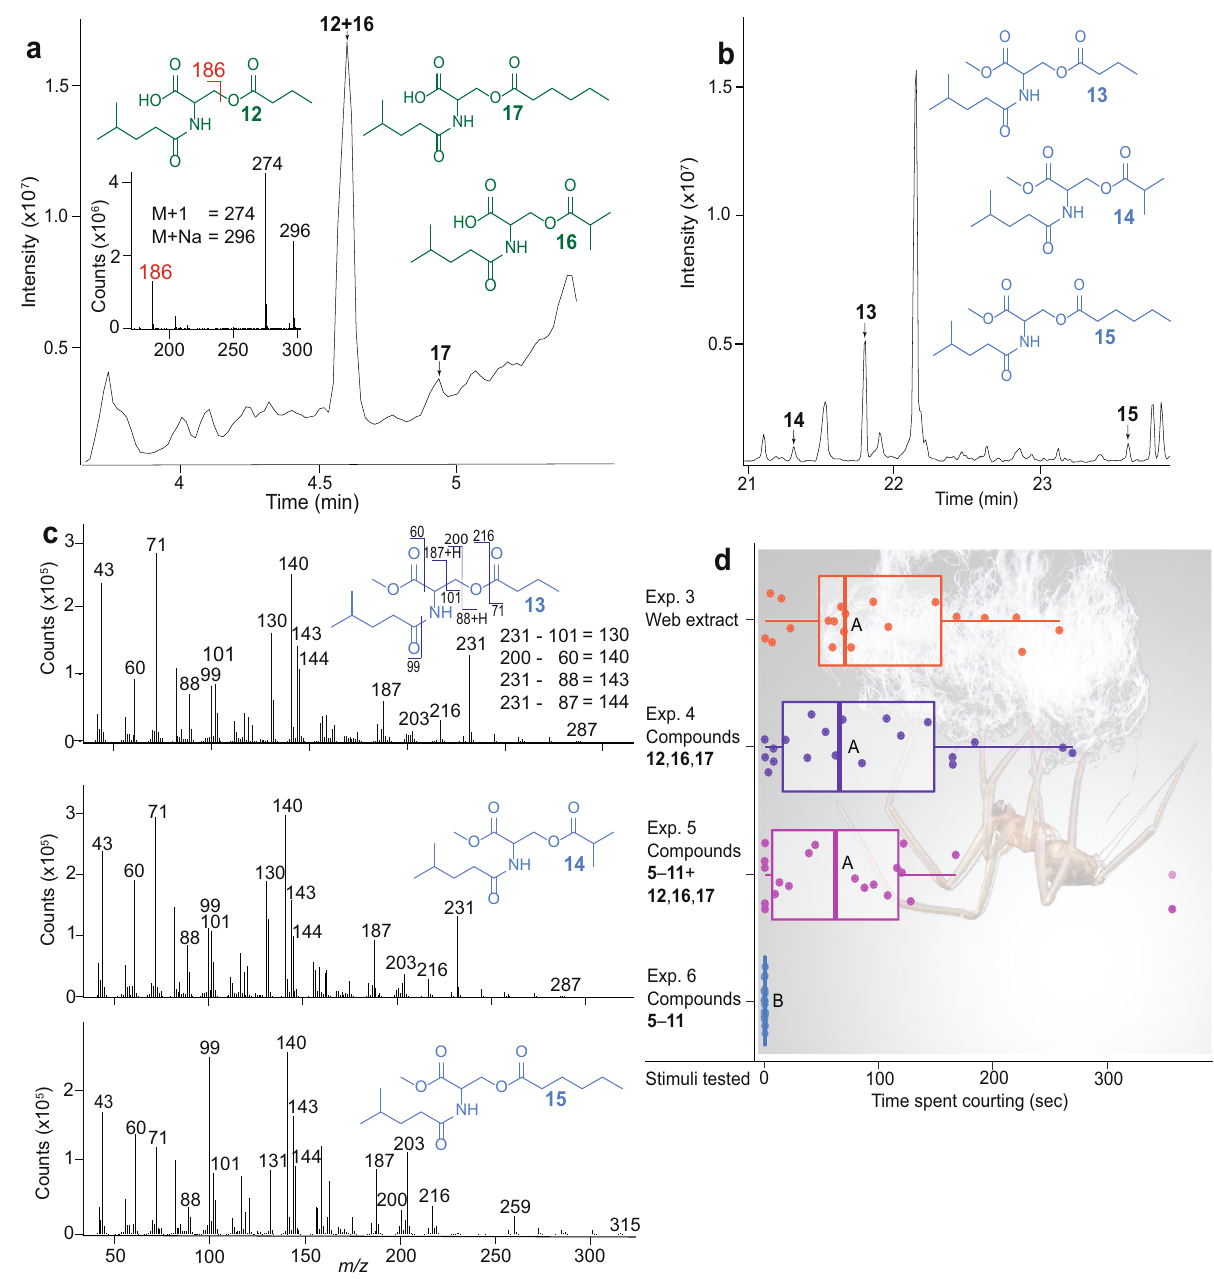
Fig. 2 Contact pheromone components of female Steatoda grossa . a High-performance liquid chromatogram (HPLC) of compounds [ N -4-methylvaleroyl- O -isobutyroyl- L -serine ( 12 ); N -4-methylvaleroyl- O -isobutyroyl- L -serine ( 16 ); N -4-methylvaleroyl- O -hexanoyl- L -serine ( 17 )] present in crude web extract of female S. grossa , and HPLC mass spectrum of 12 (with 16 coeluting). b , c Total ion chromatogram ( b ) and mass spectra ( c ) of compounds [ N -4- methylvaleroyl- O -butyroyl- L -serine methyl ester ( 13 ), N -4-methylvaleroyl- O -isobutyroyl- L -serine methyl ester ( 14 ), N -4-methylvaleroyl- O -hexanoyl- L - serine methyl ester ( 15 )] identi fi ed by gas chromatography – mass spectrometry (GC-MS) in esteri fi ed web extract of female S. grossa . d Extent of courtship by male S. grossa in response to stimuli tested in T-rod bioassays. The names of compounds 5 – 11 are reported in the caption of Fig. 1. Circles and boxplots show the time single male spiders courted in each replicate and the distribution of data (minimum, fi rst quartile, median, third quartile, maximum), respectively. Medians with different letters indicate statistically signi fi cant differences in courtship responses; Kruskal – Wallis χ 2 test with Benjamini – Hochberg correction to account for multiple comparisons, P <